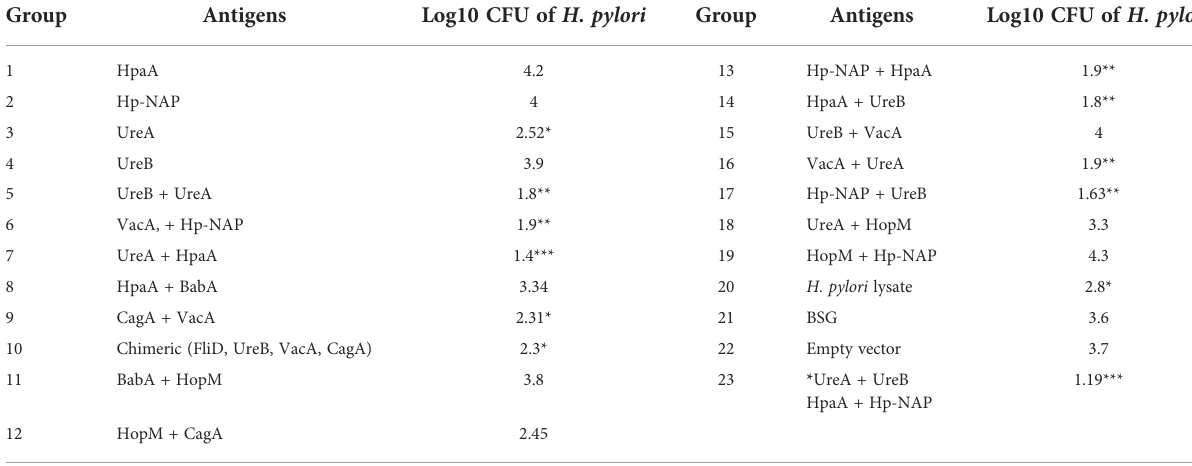
TABLE 2 Colonization of stomach by H. pylori in immunized mice. Group